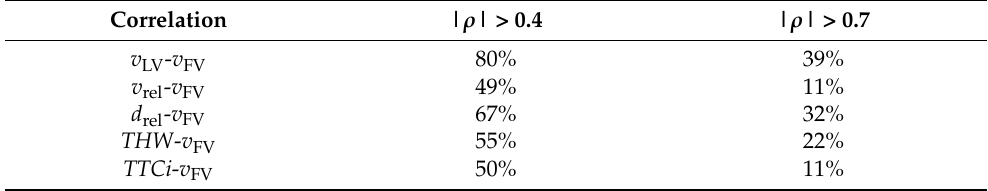
Table 1. Ratio of correlation coefficient between each parameter and following vehicle speed.